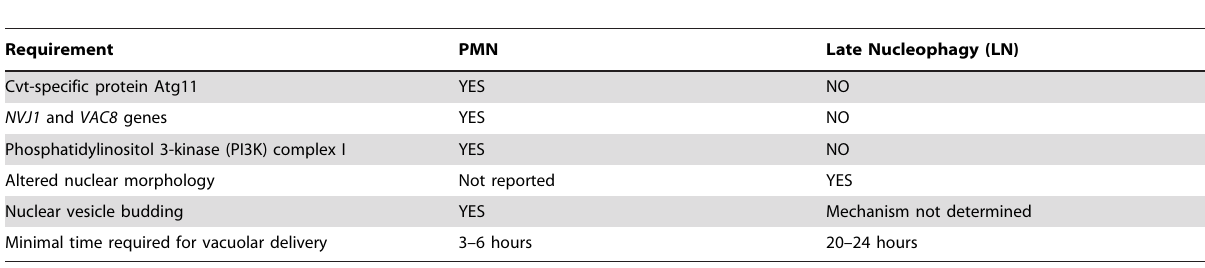
Table 2. Major requirement differences between PMN and